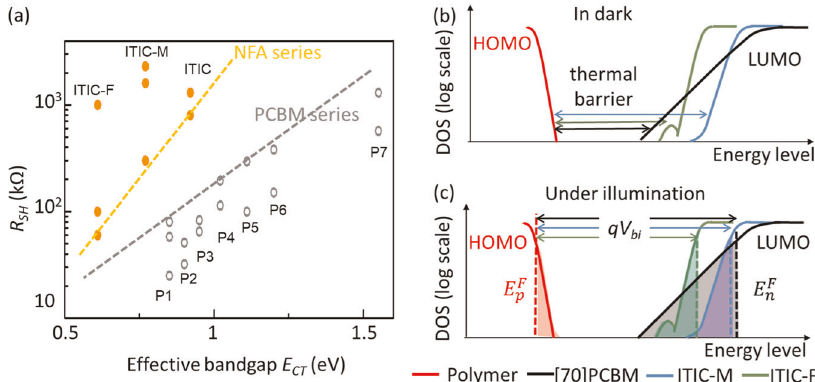
Fig. 4 Thermal noise for different effective bandgap. a Shunt resistance of organic BHJ photodiodes as a function of the effective bandgap. The orange series are devices with the same polymer donor P1 matched with different non-fullerene acceptors. The gray series are devices using different polymer donors with the acceptor [70]PCBM. The dashed lines are linear fi ts to the boundary of each series. Schematics of the electronic structures and carrier distributions for devices b in the dark and c under illumination. The shaded areas represent states fi lled up to the quasi-fermi levels E F p/n by photogenerated